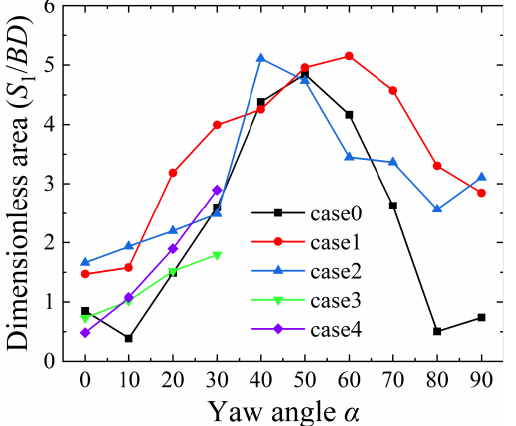
Figure 5. Dimensionless area of low-speed region.